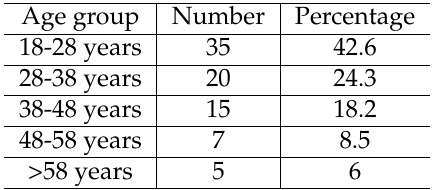
Table 1. Age wise distribution of